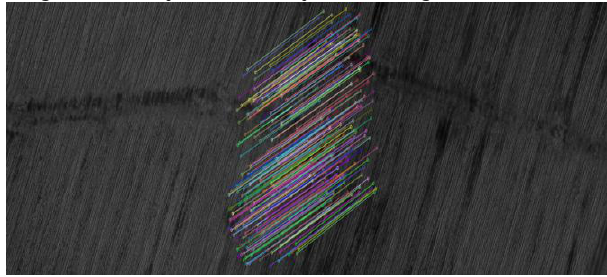
Figure 3: Matching images with repetitive